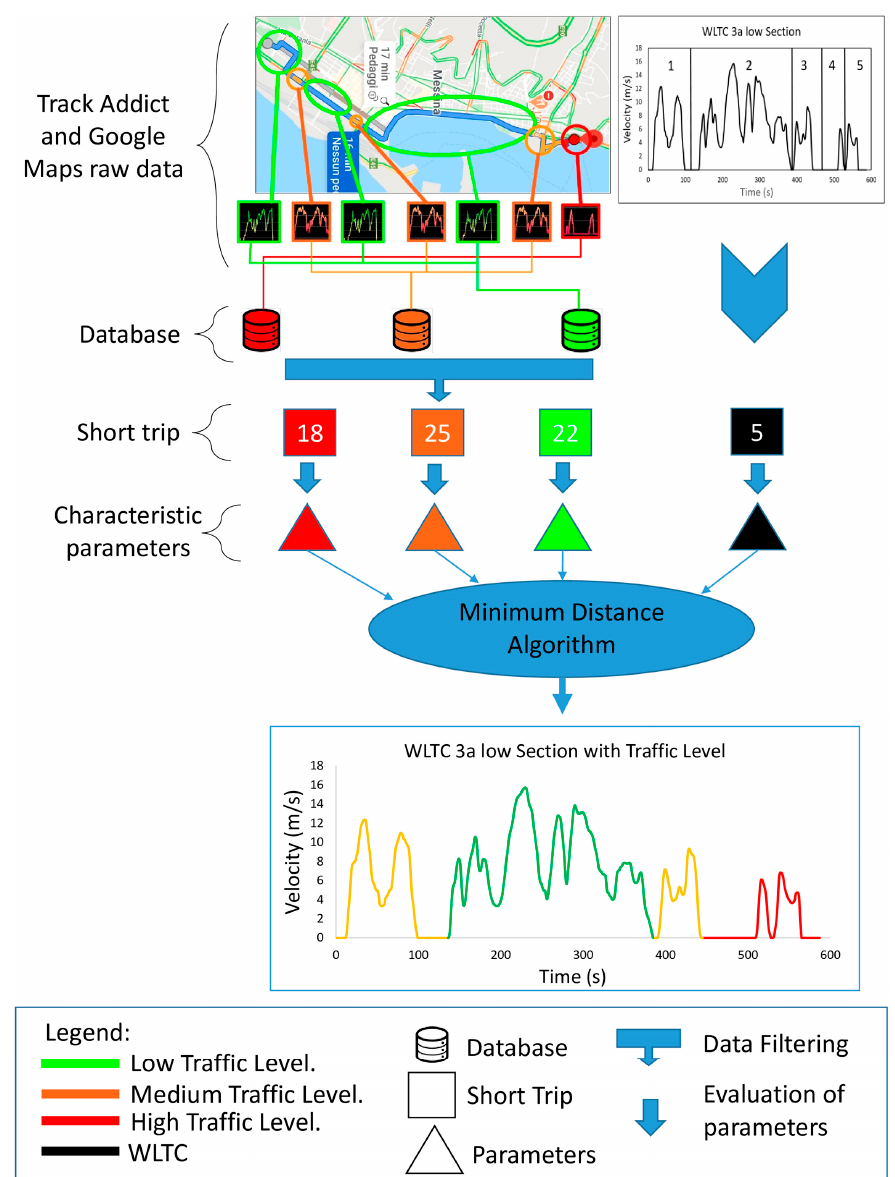
Figure 6. Data acquisition, filtering, and analysis